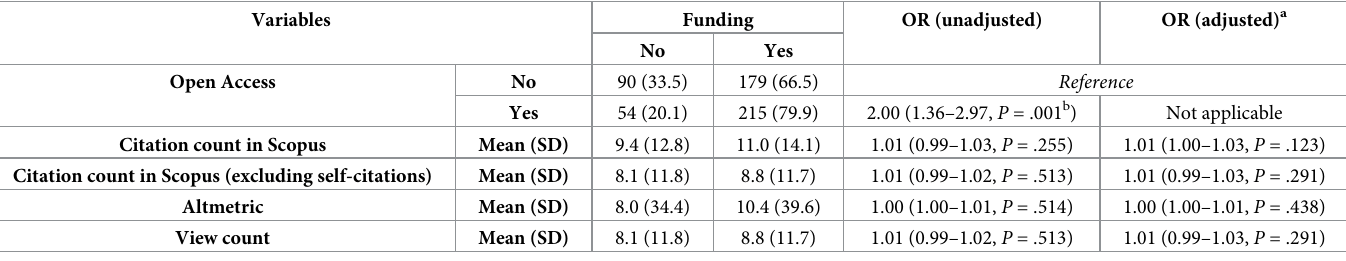
Table 4. The association between funding status and different